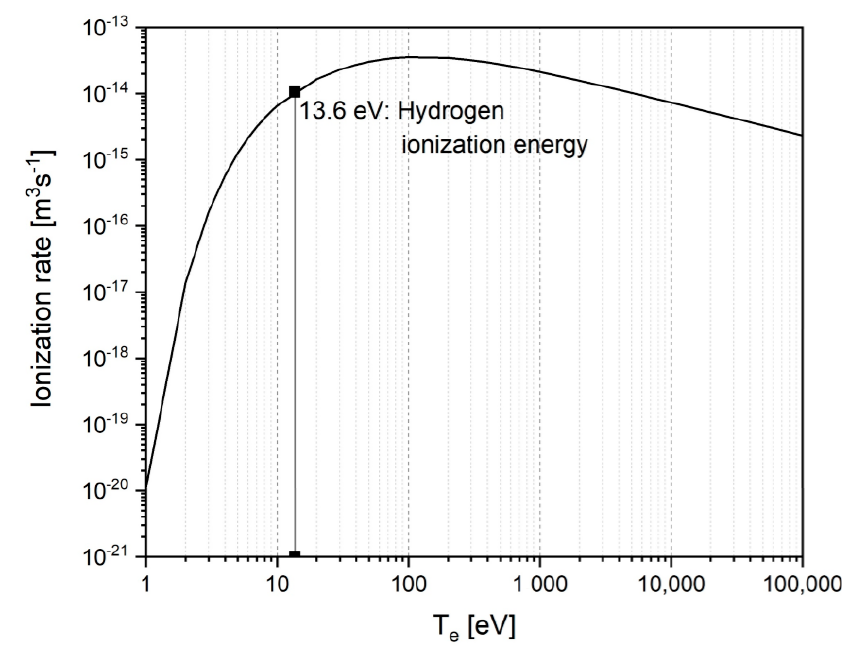
Figure 7. Ionization rate of the hydrogen atoms versus electron temperature T e [40].